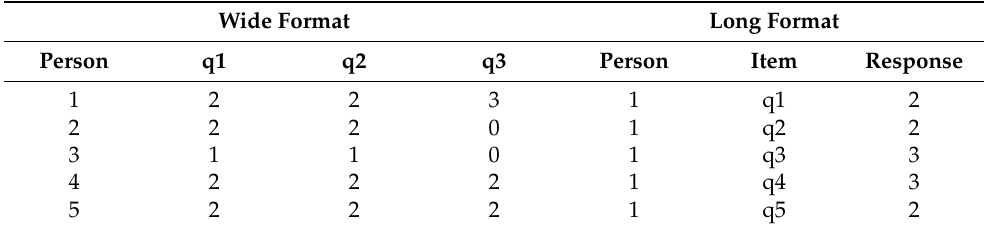
Table 1. First five rows of wide and long format data.